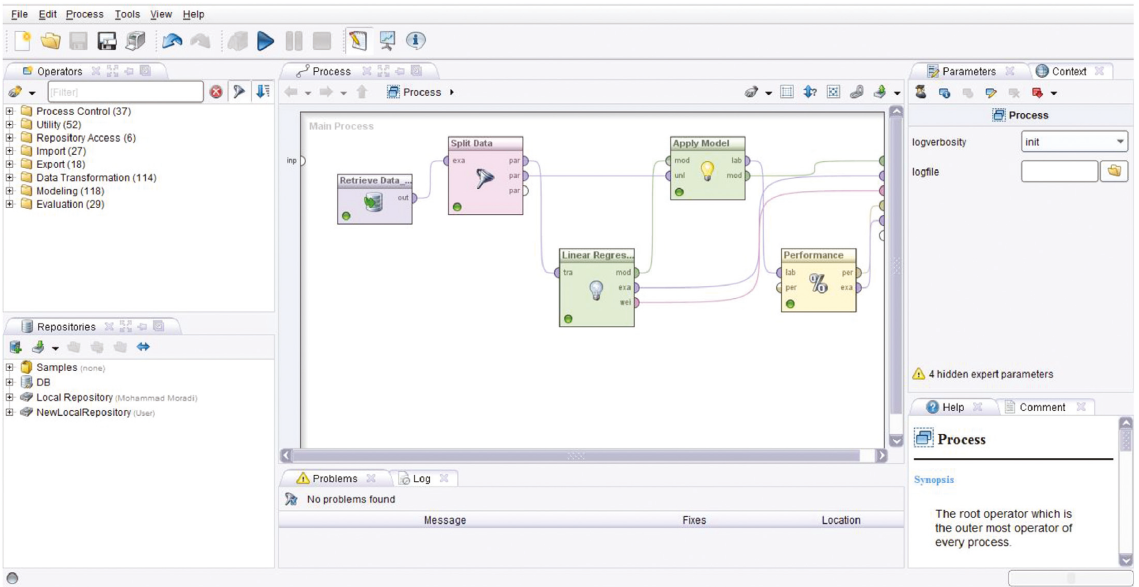
Figure 6: Operators used in Rapid Miner software to calculate regression